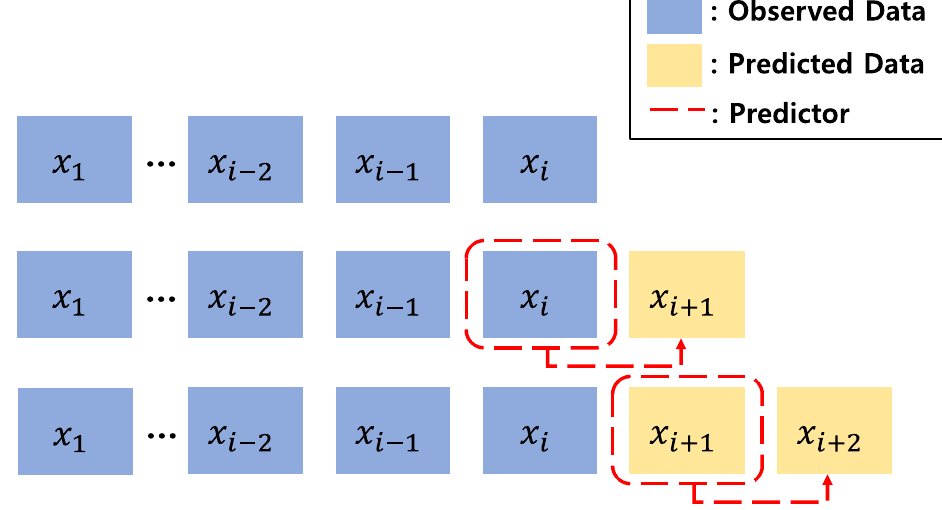
Figure 7. One-step forward LSTM network prediction method.